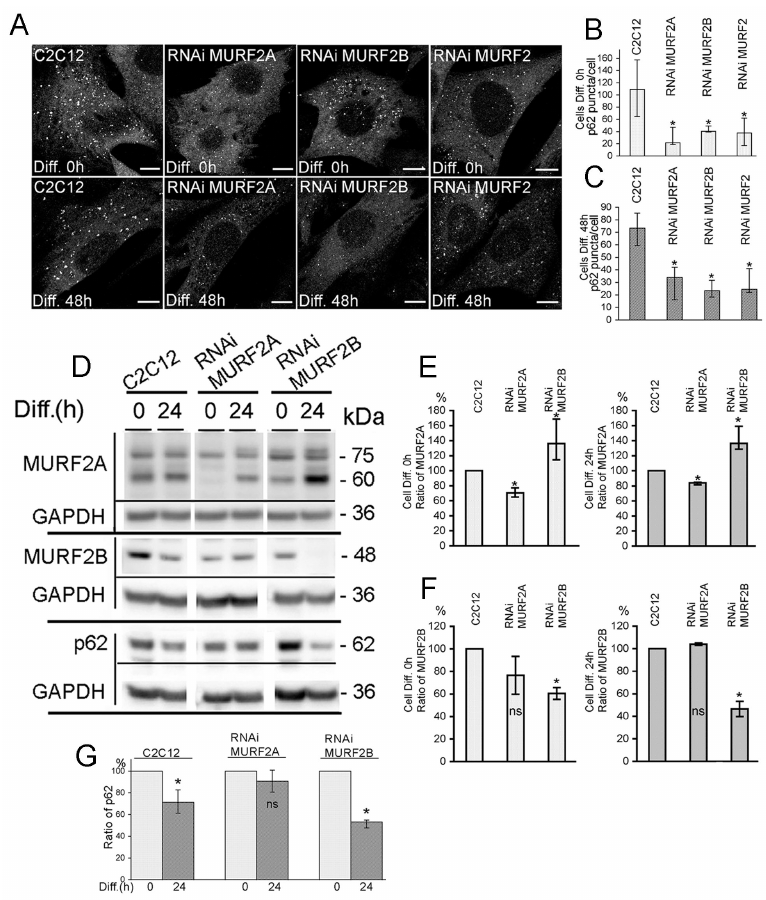
Figure 7. Analysis of autophagy in C2C12 and MURF2 RNAi cells. (A) Endogenous p62 was detected in C2C12 cells and MURF2 RNAi myoblasts (Diff. 0h) and in cells differentiated for 48h. Cells were immunostained with anti-p62 antibody and analyzed by confocal microscopy. Scale Bar: 10 µm. (B) Quantification of the p62 puncta detected in C2C12 and MURF2 RNAi myoblasts. Data were obtained from independent imunofluorescence experiments and various numbers of cells were analyzed : 8 for C2C12 cells, 6 for RNAi MURF2A cells, 5 for RNAi MURF2B cells and 13 for RNAi MURF2 cells. Differences were evaluated by the Kruskal-Wallis test. Medians and quartiles are shown in the histograms. Compared to C2C12 myoblasts, the MURF2 RNAi cells showed significant differences (*, P<0.05). (C) Quantification of the p62 puncta in the C2C12 and MURF2 RNAi 2 after 48h of differentiation. Data were obtained from independent imunofluorescence experiments, and various numbers of cells were analyzed: 12 for C2C12 cells, 24 for RNAi MURF2A cells, 9 for RNAi MURF2B cells and 12 for RNAi MURF2 cells. Medians and quartiles ranges are shown in the histograms. Multiple comparaisons of median of C2C12 and MURF2 RNAi cells by the Kruskal-Wallis test showed significant differences (*, P<0.05). (D) Representative immunoblot analyses of endogenous proteins expressed during differentiation of C2C12 and MURF2 RNAi cells. Lysates were obtained from myoblasts (Diff. 0) and after 24h of differentiation. Western blots were probed with the indicated antibodies. (E) Quantification of MURF2A protein in C2C12 and MURF2 RNAi cells after 0h and 24h of differentiation. For each time point of differentiation, data were obtained from 3 independent western blot experiments. Medians and quartiles ranges are shown in the histograms. Multiple comparaisons of median of C2C12 and MURF2 RNAi cells by the Kruskal-Wallis test showed significant differences (*, P<0.05). (F) Quantification of MURF2B protein in the C2C12 and MURF2 RNAi cells after 0h and 24h of differentiation. For each time point of differentiation, data were obtained from 2 independent western blot experiments. Medians and quartiles ranges are shown in the histograms. Multiple comparaisons of median of C2C12 and MURF2 RNAi cells by the Kruskal-Wallis test showed significant differences (*, P<0.05). (G) Endogenous p62 quantification in undifferentiated (Diff. 0h) and differentiated (Diff. 24h) C2C12 and MURF2 RNAi cells. Cells were lysed with RIPA buffer and analyzed by Western blots with anti-p62 antibody. For each cell line, the amounts of p62 detected after differentiation were normalized with p62 present in undifferentiated cells. Data were obtained from several independent Western blot experiments: 6 for C2C12 cells (Diff. 0h and 24h), 3 for RNAi MURF2A (Diff. 0h), 2 for RNAi MURF2A (Diff. 24h) and 3 for RNAi MURF2B (Diff. 0h and 24h). Differences were evaluated with the Kruskal-Wallis test. Medians and quartiles are shown in the histograms. Compared to undifferentiated cells (Diff. 0h), non significant differences (ns) and significant differences (*) were observed (P<0.05). doi: 10.1371/journal.pone.0076140.g007 PLOS ONE |